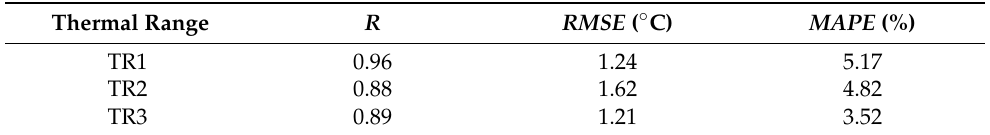
Table 7. Example 3.0.1. Statistical parameters for the courtyard measured temperature in each selected courtyard of each